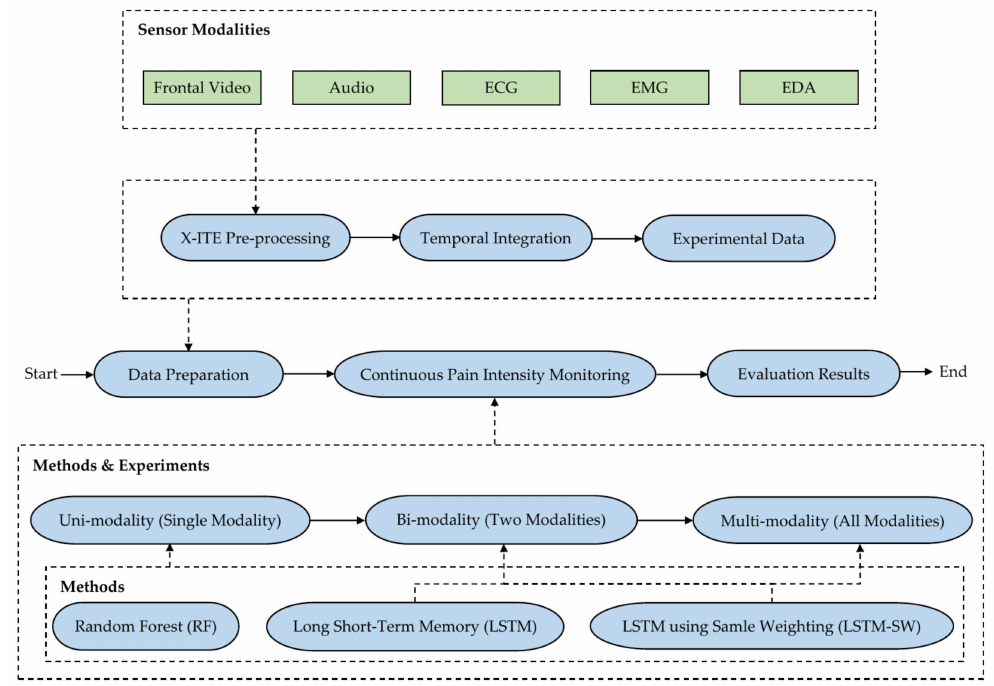
Figure 1. The general pipeline of the proposed automatic system for continuous monitoring of pain